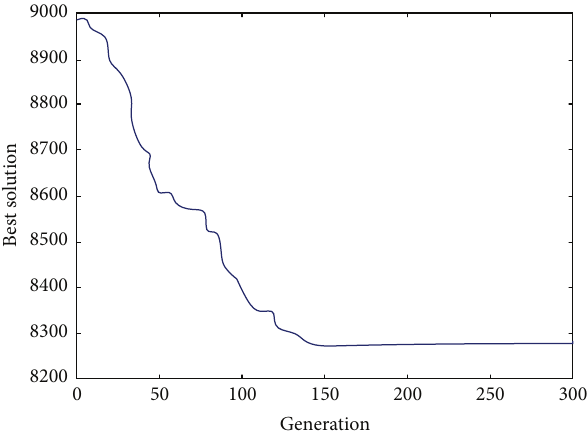
Figure 4: The evolution of best solution when 𝑚 = 3, 𝑛 = 6 .